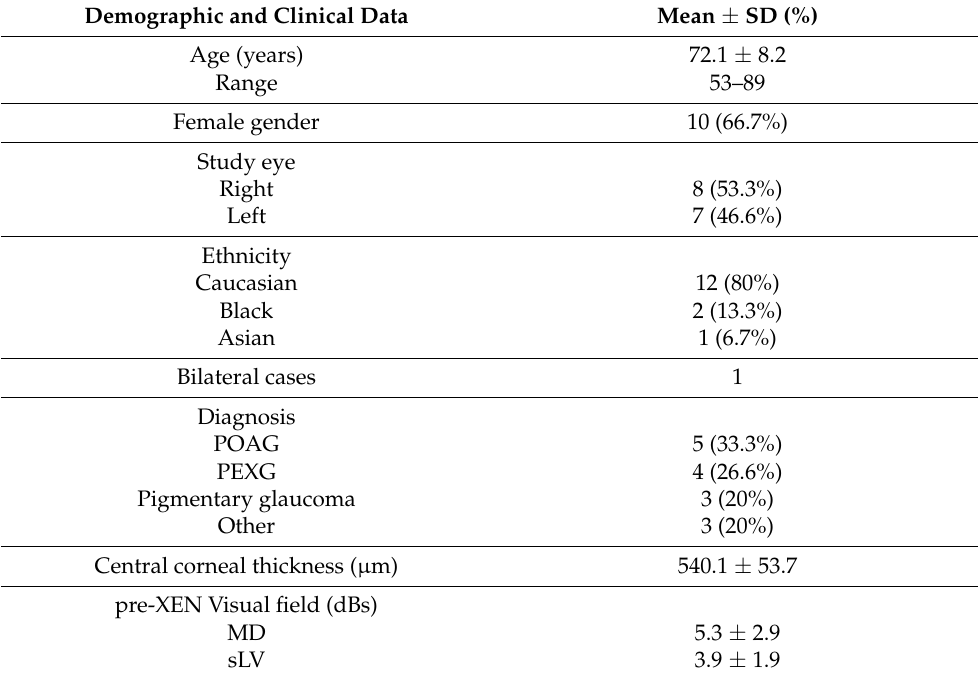
Table 1. Baseline demographics and clinical characteristics of study